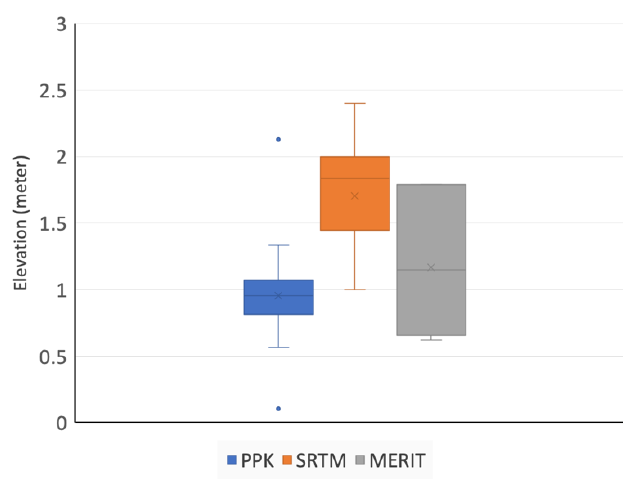
Figure 4. Comparison of Shuttle Radar Topography Mission (SRTM) and Multi-Error-Removed- Improved-Terrains (MERIT DEMs) with post-processed kinematic (PPK) ground truth elevation data.